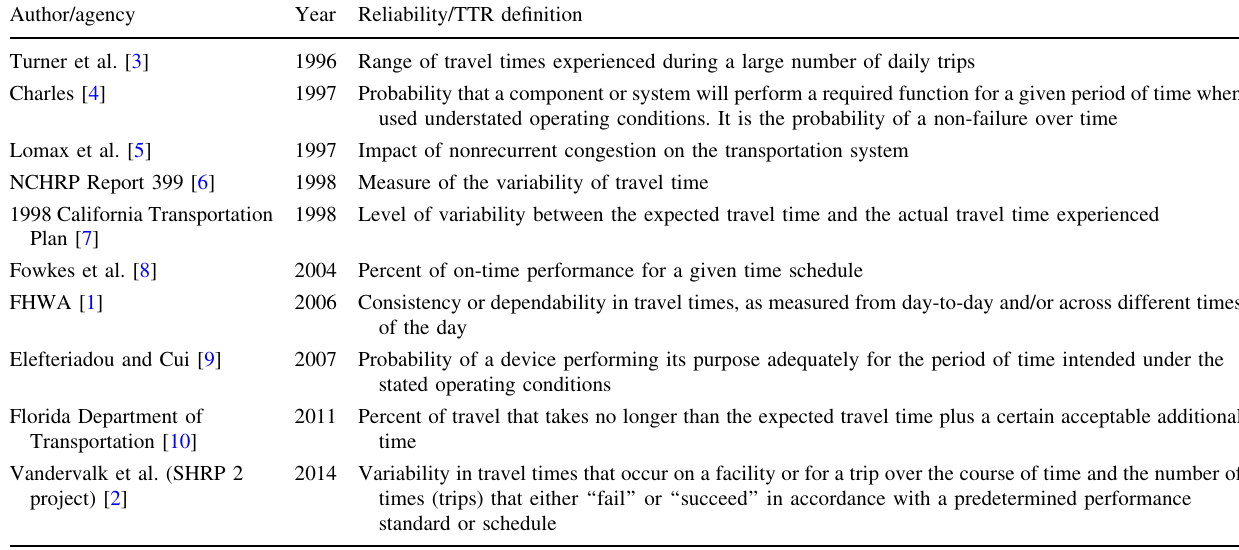
Table 1 Summary of existing TTR definitions